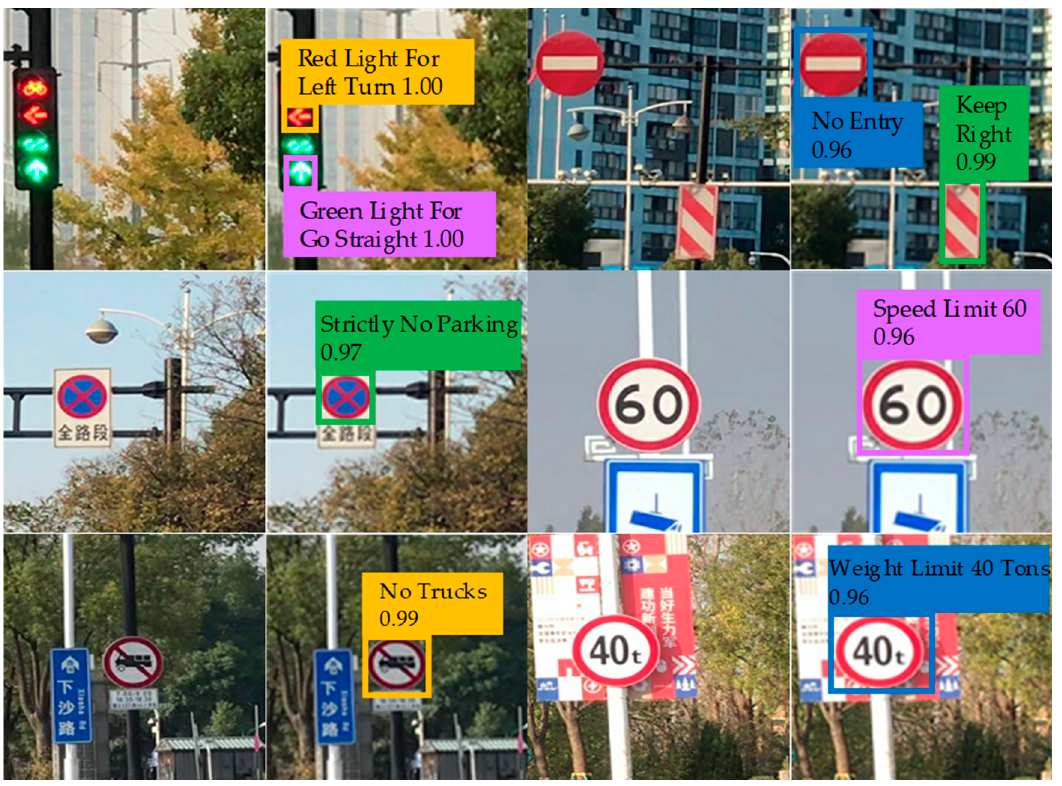
Figure 7. Part of the recognition results.